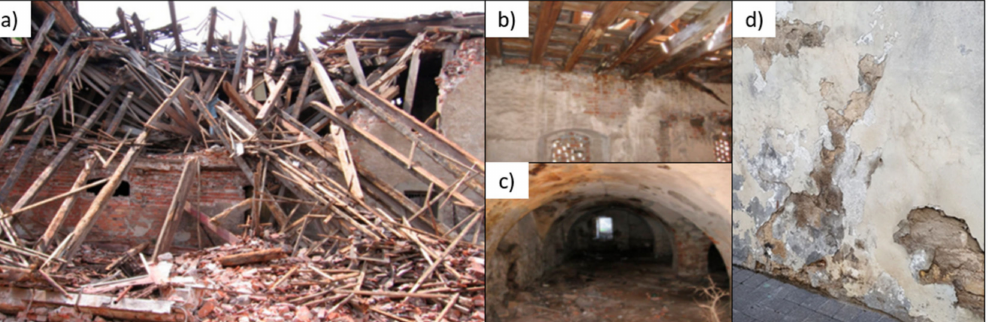
Figure 1. Examples of moisture on buildings: ( a ) granary building—basement [2]; ( b ) granary building—1st floor [2]; ( c ) a building after disaster [2]; ( d ) damage of bricks and mortar caused